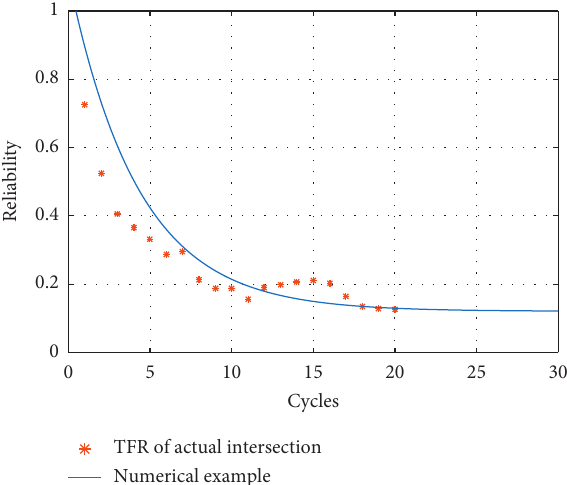
Figure 9: Green time ratio: the reliability of the signalized in- tersection approach.